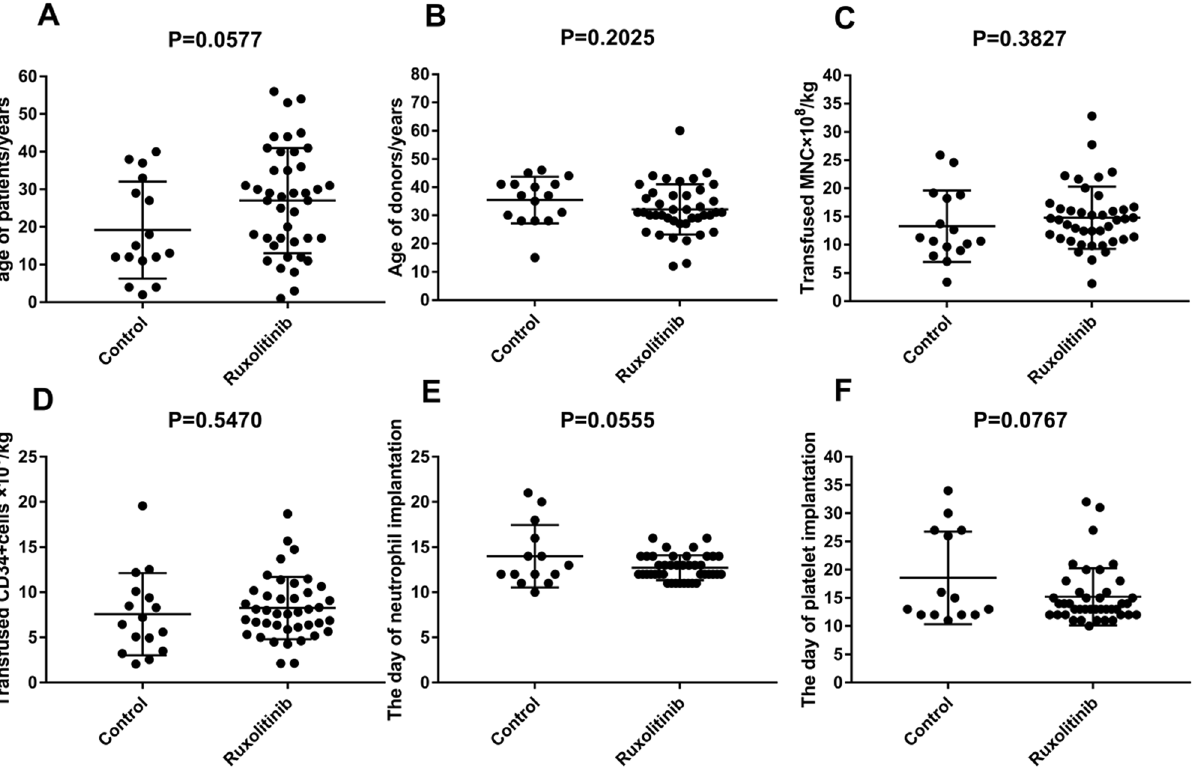
Figure 1. Comparison of characteristics between the control and ruxolitinib groups. Age of patients ( A ), age of donors ( B ), transfused MNC × 10 8 /kg ( C ), transfused CD34 + cells × 10 6 /kg ( D ), day of neutrophil ( E ) and platelet ( F ) engraftment. (Graphpad prism 8.0.1 https:// www. graph pad. com/ scien tific- softw are/